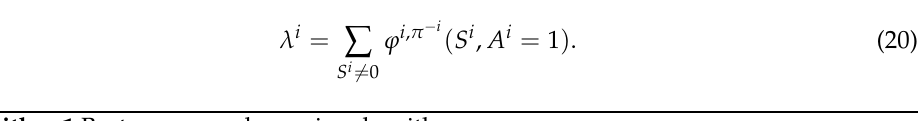
Algorithm 1 Best response dynamics